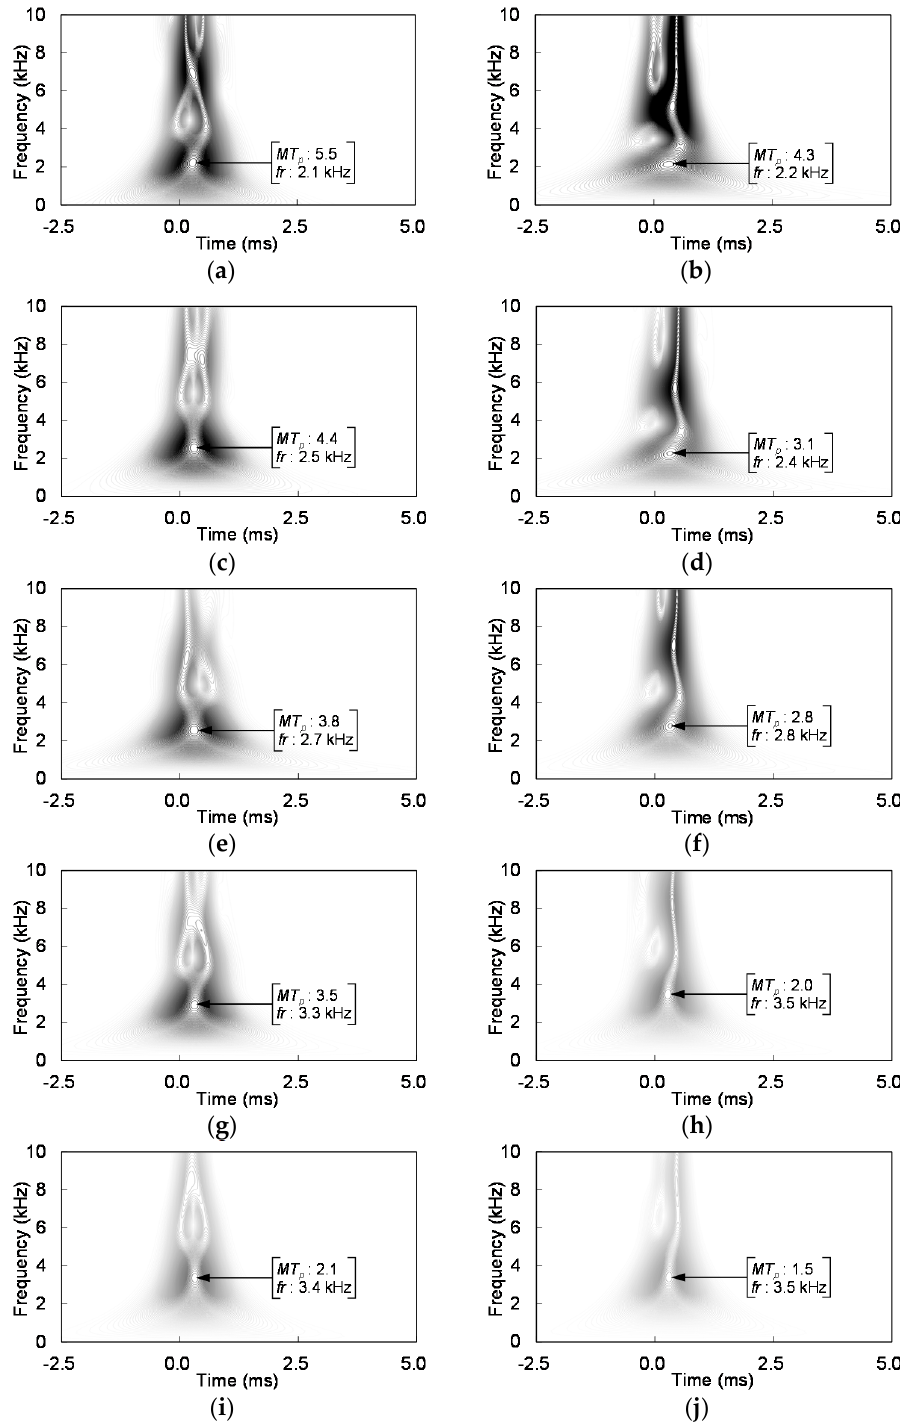
Figure 12. Wavelet transform of sound waves at selected measurement locations: ( a ) L = 0 mm for 8 mm thick acrylic plate; ( b ) L = 0 mm for 15 mm thick acrylic plate; ( c ) L = 20 mm for 8 mm thick acrylic plate; ( d ) L = 20 mm for 15 mm thick acrylic plate; ( e ) L = 40 mm for 8 mm thick acrylic plate; ( f ) L = 40 mm for 15 mm thick acrylic plate; ( g ) L = 80 mm for 8 mm thick acrylic plate; ( h ) L = 80 mm for 15 mm thick acrylic plate; ( i ) L = 150 mm for 8 mm thick acrylic plate; and ( j ) L = 150 mm for 15 mm thick acrylic plate.